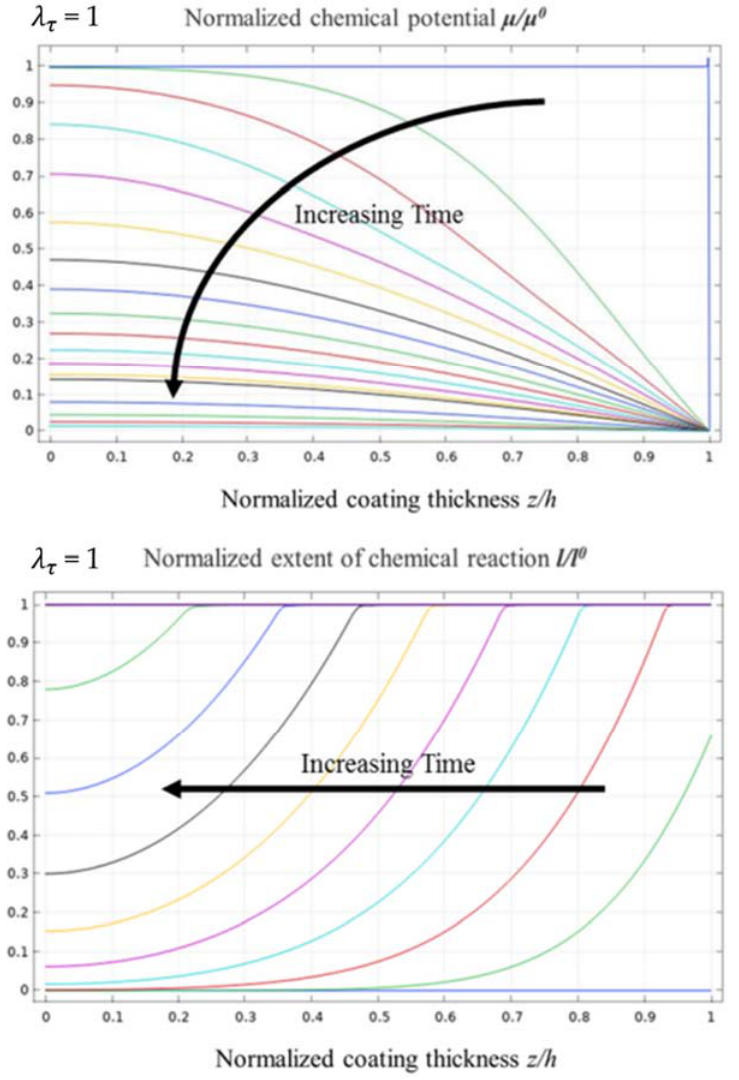
Figure 3. Evolution curves of normalised chemical potential and normalised chemical reaction degree when λ τ = 1.